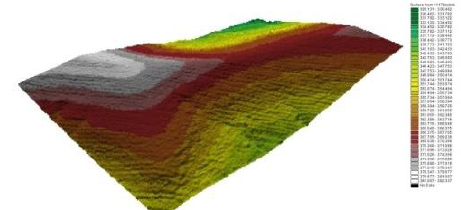
Figure 11. 3D view for a DEM created from the original LiDAR data of point cloud density of 0.2705pts/m 2 .